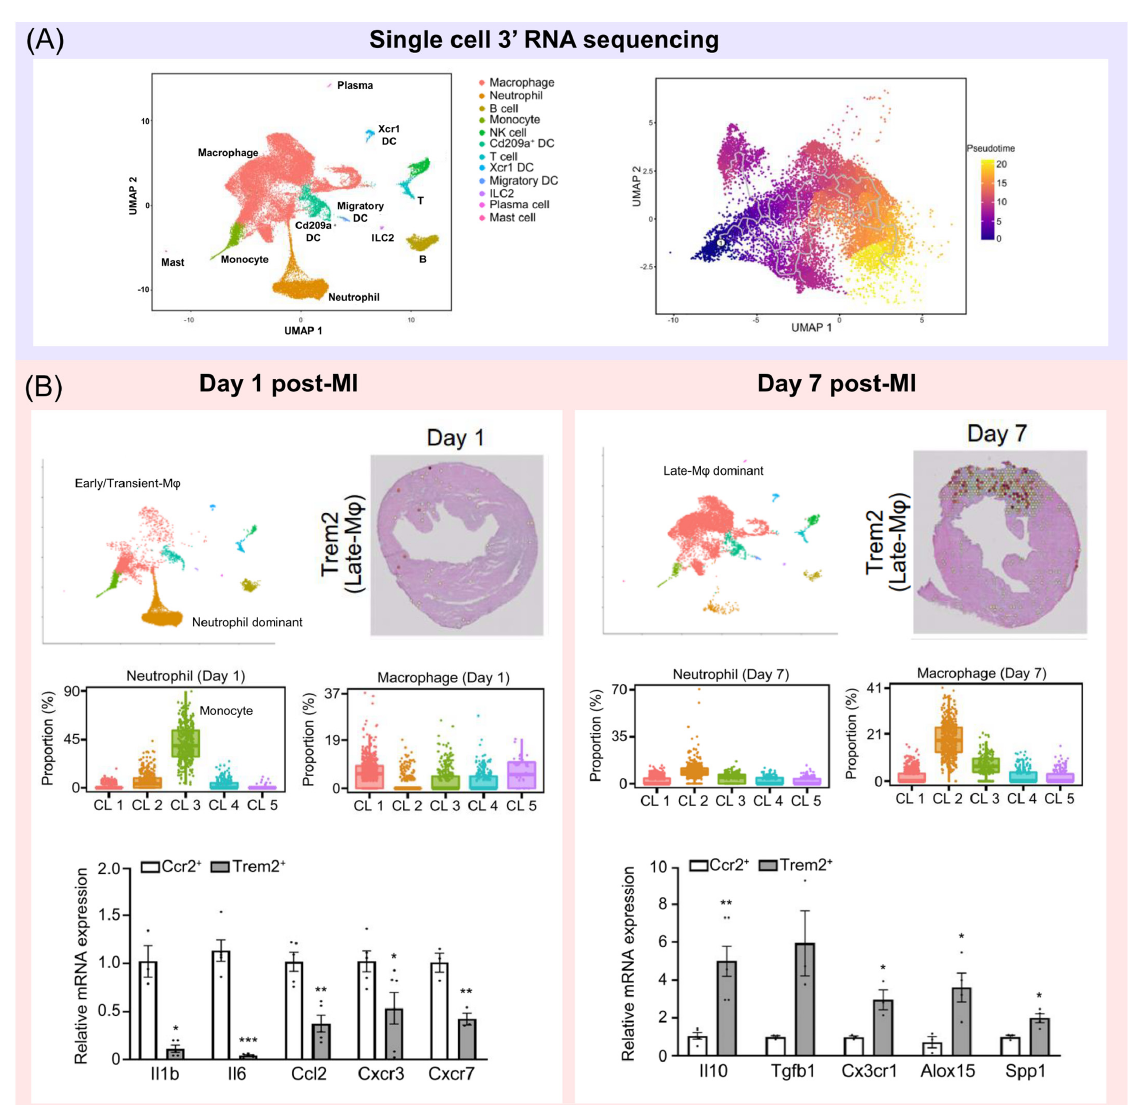
Figure 3. The dynamics of immune cells over time and the presence of Trem2 hi macrophages in mouse hearts following myocardial infarction [10]. ( A ) Time-dependent immune cell dynamics vis- ualized in two-dimensional uniform manifold approximation and projection. Each point represents a single cell, and cell types are color-coded. The results of single-cell trajectory analysis showed a sequential differentiation process from monocytes to late macrophages. ( B ) The proportion of neu- trophils and macrophages among the total immune cells infiltrated into the myocardial tissue changes over time after MI. The early phase (day 1) is dominated by neutrophils and monocytes, whereas the subacute phase (day 7) shows a population dominated by macrophages, with high ex- pression of the Trem2 gene, as demonstrated by spatial transcriptome sequencing. The mRNA ex- pression levels of pro- and anti-inflammatory genes were compared between early macrophages (day 1 post-MI) and late macrophages expressing Trem2 (day 7 post-MI), revealing an upregulation of anti-inflammatory genes in Trem2 + late macrophages. Unpaired two-tailed t-test was used to de- termine the statistical significance. * p < 0.05, ** p < 0.01, *** p < 0.001.